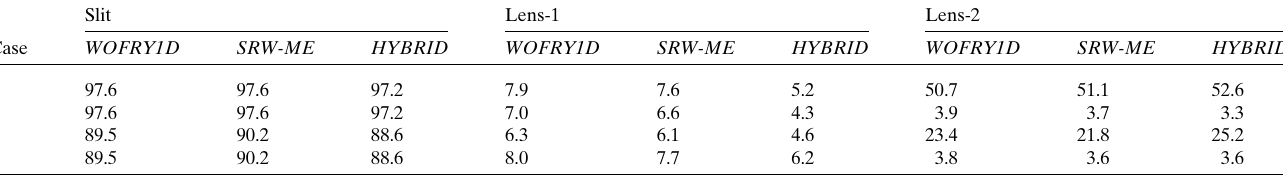
Table 3 Comparison of beam intensity attenuation in percent by the slit, lens-1 and lens-2 for the partially coherent beam for the four cases studied. The WOFRY1D data shown here come after combining the horizontal and vertical wavefronts using the outer product. Each profile corresponds to the intensity integrated along its perpendicular direction. Slit Lens-1